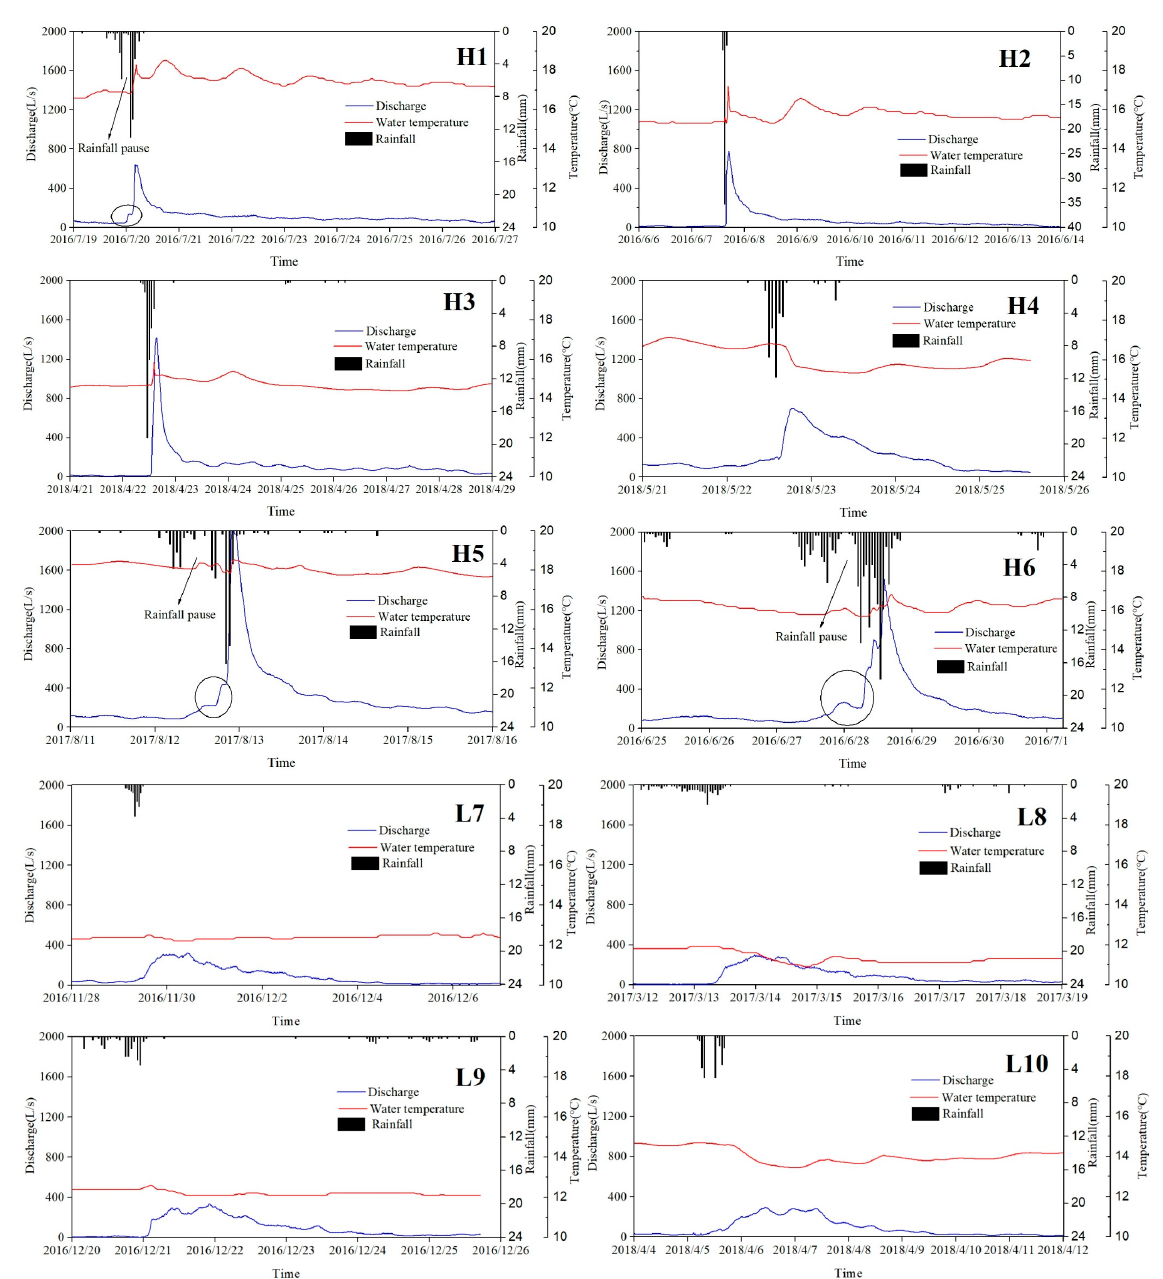
Figure 4. Rainfall–discharge–water-temperature response curve of 10 precipitations. Table 3. Characteristic parameters of rainfall discharge curve.